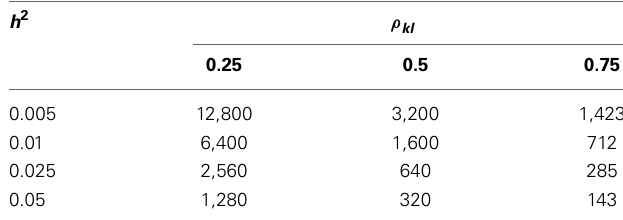
Table 9 | The required sample size that makes the HE regression more powerful than the conventional single-marker linear regression.